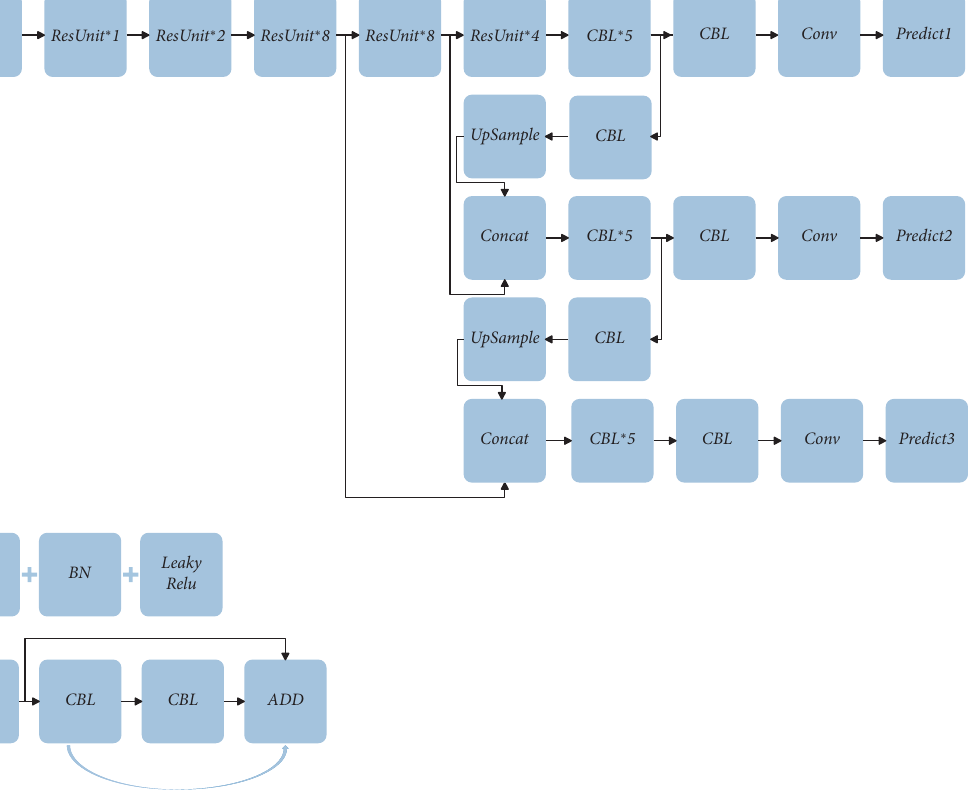
Figure 1: YOLOv3 network structure.